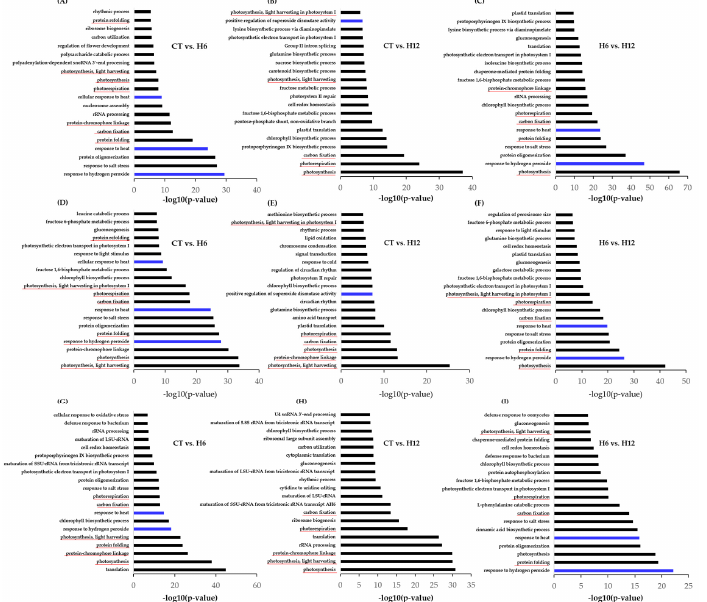
Figure 3. Significantly (FDR (padj) < 0.05)-enriched biological processes (BPs) for differentially- expressed genes (DEGs) of all three comparisons in the three cultivars subjected to heat treatment. ( A – C ) The top 20 significantly-enriched BPs for DEGs in Jopum for CT vs. H6, CT vs. H12, and H6 vs. H12, respectively. ( D – F ) The top 20 significantly-enriched BPs for DEGs in Keumkang for CT vs. H6, CT vs. H12, and H6 vs. H12, respectively. ( G – I ) The top 20 significantly-enriched BPs for DEGs in Olgeuru for CT vs. H6, CT vs. H12, and H6 vs. H12, respectively. BPs underlined in red indicate that they are shared among the three cultivars. Blue bars indicate significantly-enriched BP ‘Cellular response to heat’ or ‘Reactive oxygen species metabolic process’. CT, untreated control; H6, 6-h heat treatment; H12, 12-h heat treatment. Supporting data can be found in Supplementary File